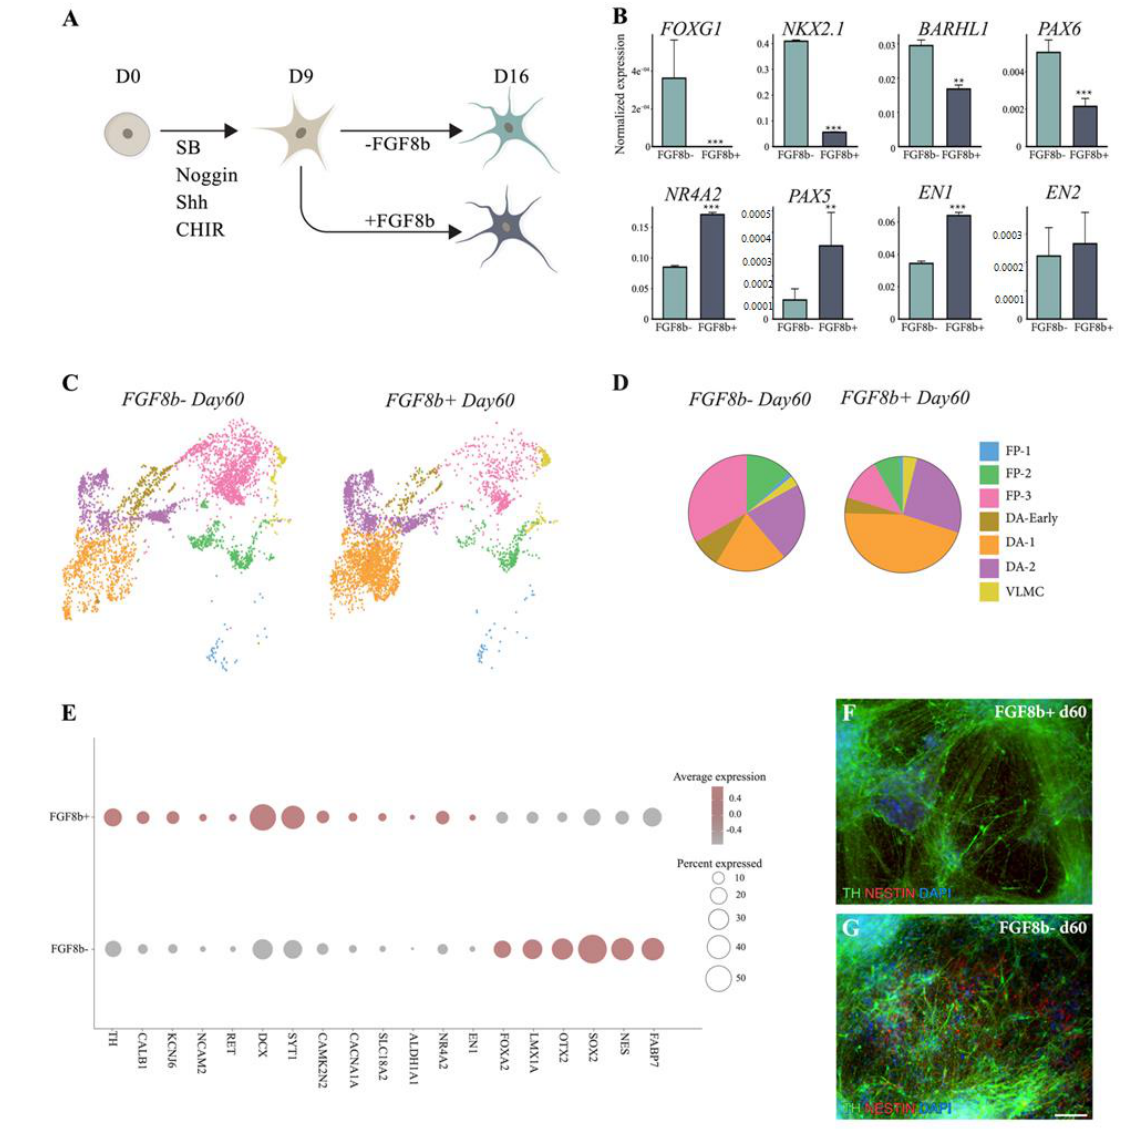
Figure 3. Fibroblast growth factor 8 (FGF8b) facilitates progenitor transition into mature DA neurons. ( A ) Schematic overview of the experimental design. ( B ) Bar plots showing expression of rostral and caudal mesencephalic markers with and without FGF8b treatment at 2 months from single-cell dataset. Data represent mean ± SEM, ** p < 0.01, *** p < 0.001. ( C ) UMAP embeddings showing cells from 60-day VM culture with and without FGF8b colored by cell types. ( D ) Pie chart showing cell-type proportion with and without FGF8b at 2 months. ( E ) Dot plot showing percent of cells expressing early and late DA markers in VM culture with and without FGF8b at 2 months. ( F ) Immunofluorescence staining of TH/NESTIN with and ( G ) without FGF8b treatment at 2 months VM culture. Scale bars, 100 µ m. Nuclei were stained with